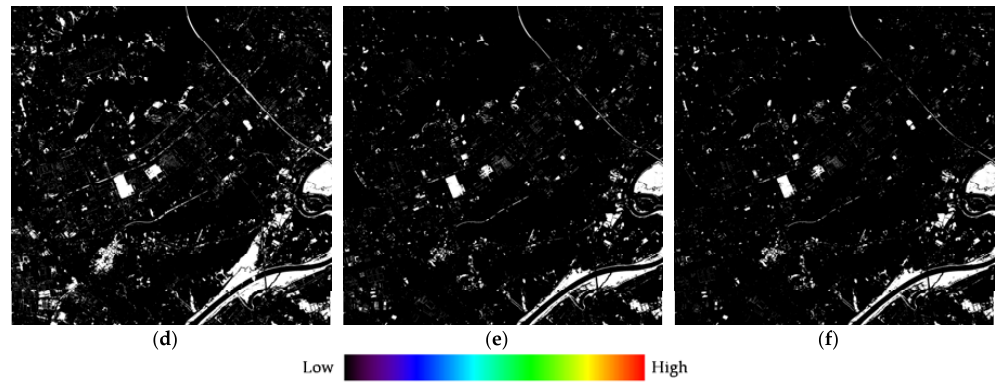
Figure 4. The change intensities with rainbow colors of ( a ) CVA; ( b ) IRMAD; ( c ) ISFA, and the binary change maps of ( d ) CVA; ( e ) IRMAD; ( f ) ISFA.